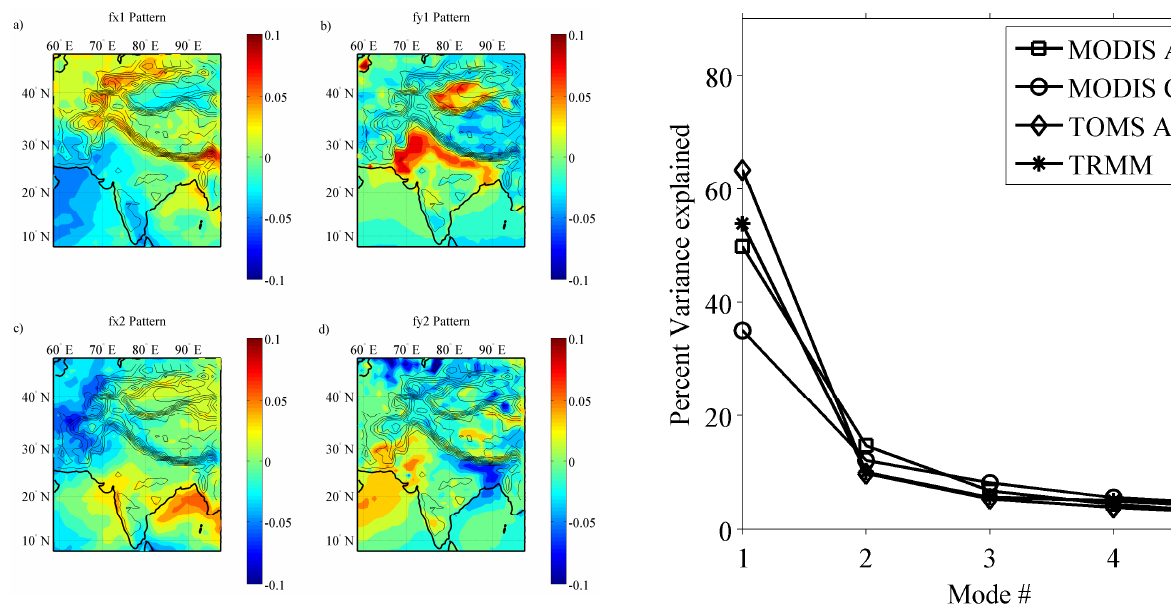
Fig. 11. The first two spatial patterns of MODIS COD ( f x 1 , f x 2 ) Figure 11: The first two spatial patterns of MODIS COD (fx1, fx2) and MODIS AOD Fig. 12. Distribution of the relative contribution of the first 5 modes and MODIS AOD ( f y 1 , f y 2 ) that explains the maximum covariance Figure 12: Distribution of the relative contribution of the first 5 modes to the overall to the overall spatial variance for MODIS AOD, MODIS COD, between the two fields. (fy1, fy2) that explains the maximum covariance between the two fields. TOMS AI and TRMM spatial variance for MODIS AOD, MODIS COD, TOMS AI and TRMM precipitation.